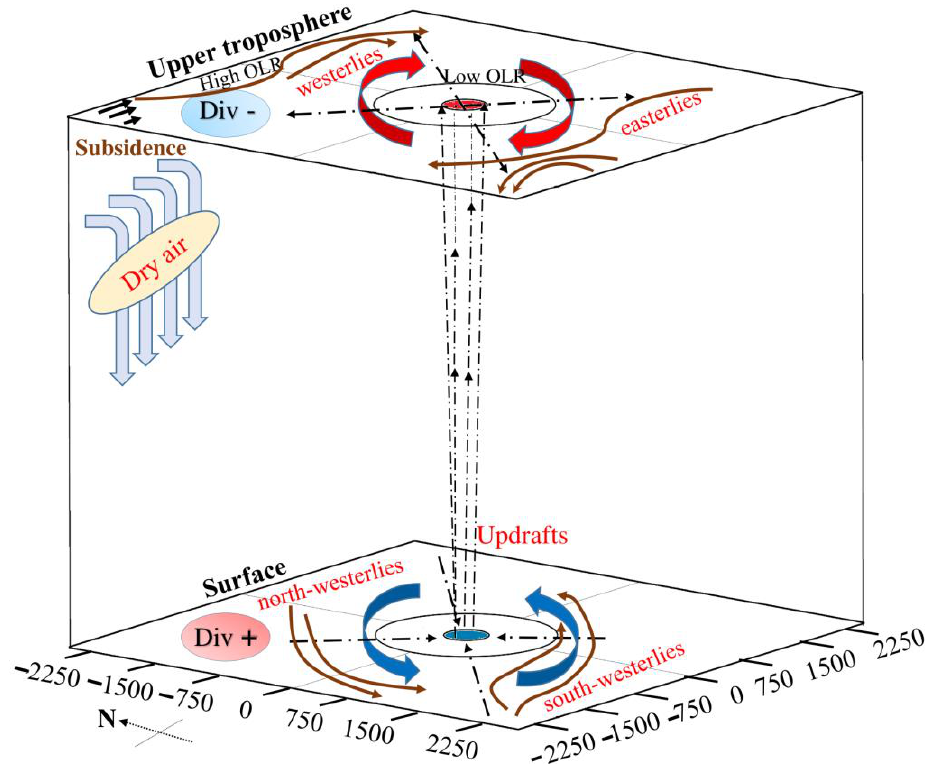
Figure 10. The schematic diagram illustrates low-level cyclonic circulation (arrows in blue colour) associated with the confluence of north-westerlies and south-westerlies (arrows in grey colour), upper-level anti-cyclonic circulation (arrows in red colour) embedded between poleward westerlies and equatorward easterlies (arrows in grey colour), and strong updrafts throughout the troposphere around the vortex centre. An OLR dipole with low OLR co-locates with the upper-level divergence region (red circle) around the vortex centre and high OLR (beyond 750 km) co-locates with the upper-level convergence region (blue circle) in the west-northwest direction, where there is strong subsidence and advection of less moist air throughout the mid-troposphere of the northwest quadrant.